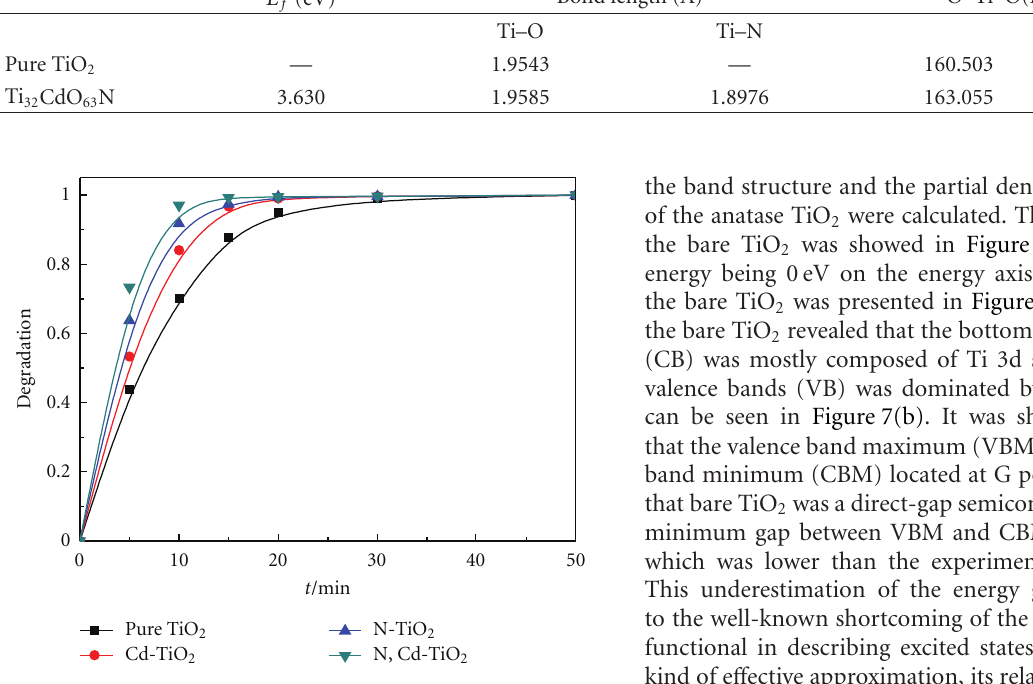
photoexcitation. The electron-hole pair can separate more easily and recombine slower, and the photocatalysts show a better photocatalytic performance. This was one reason for N, Cd codoped TiO 2 showed a higher